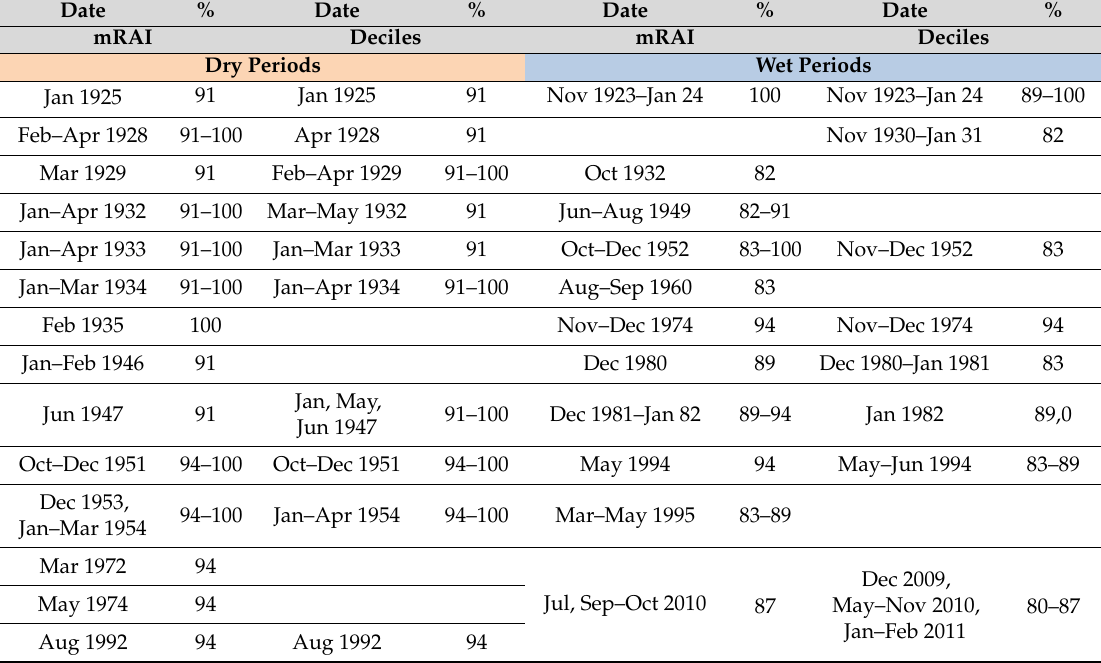
Table A3. Sub-region Eastern Europe—overview on the TOP20 months with the highest spatial extent of dry and wet periods within the study period 1924–2015.